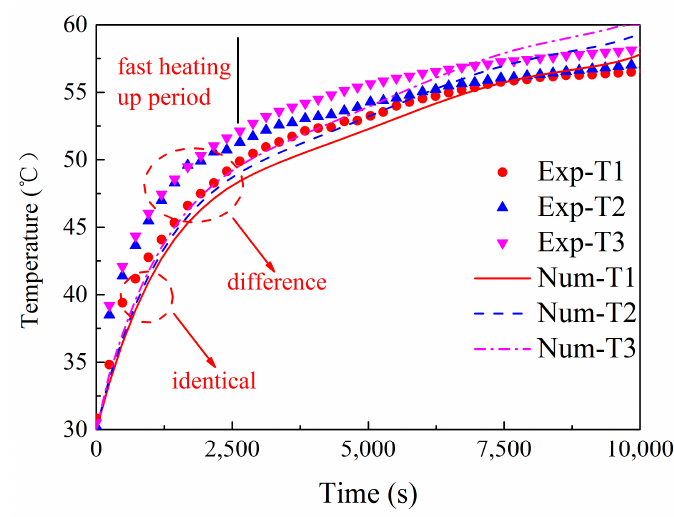
Figure 8. Experimental and numerical temperature profiles of thermocouples inside the TES unit over time for Case 1.